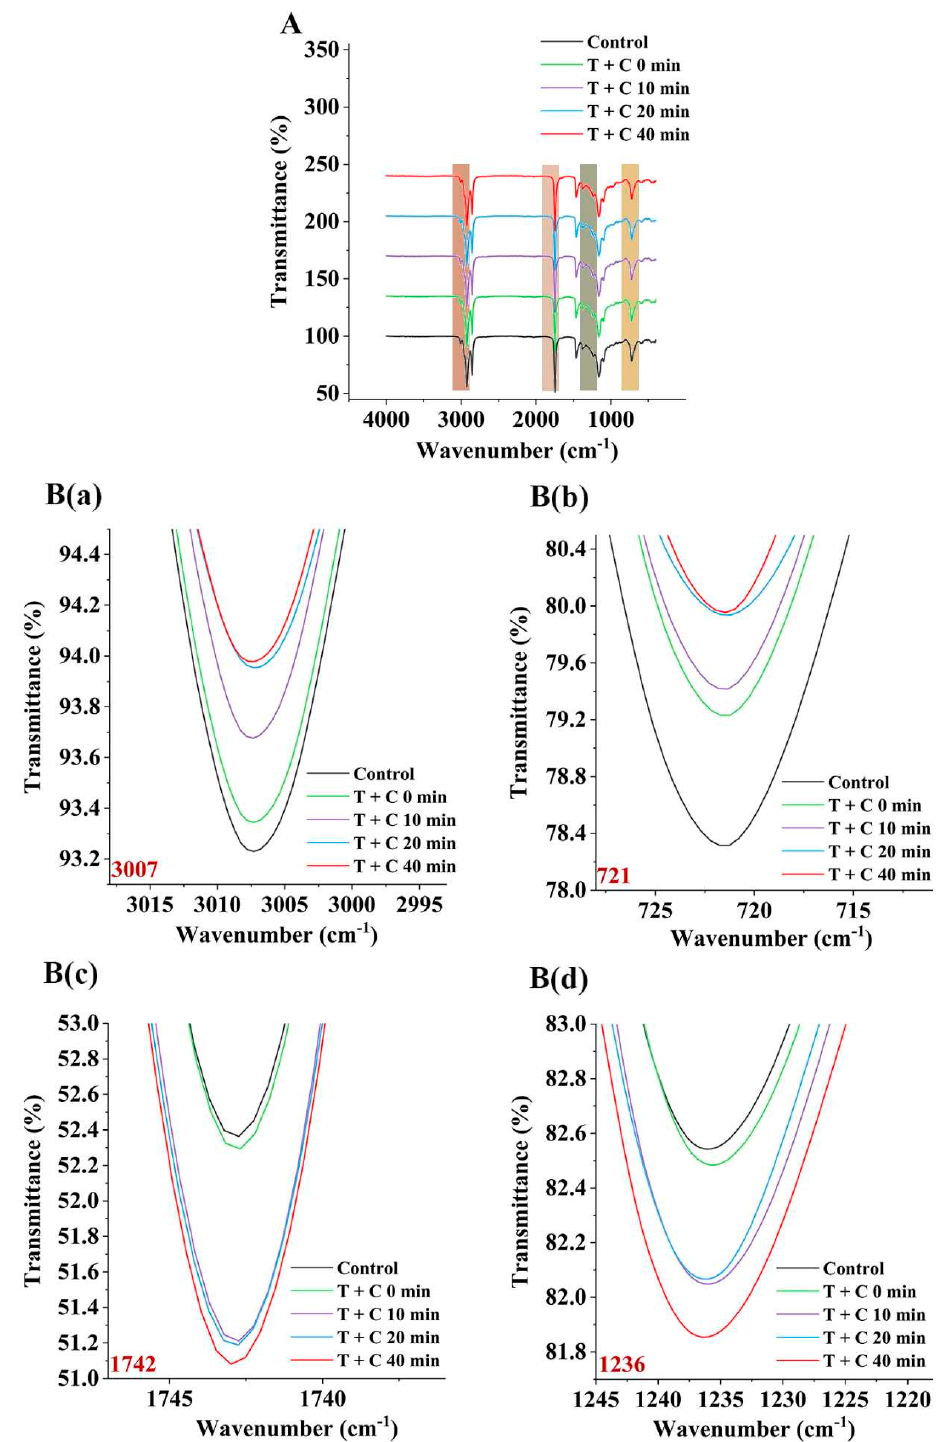
Figure 5. FT-IR spectra of triolein added with catechin heated for different times at 160 ◦ C ( A ); Several characteristic peaks of ( A ): 3007 cm − 1 ( B ) ( a ), 721 cm − 1 ( B ) ( b ), 1742 cm − 1 ( B ) ( c ), 1236 cm − 1 ( B ) ( d ).